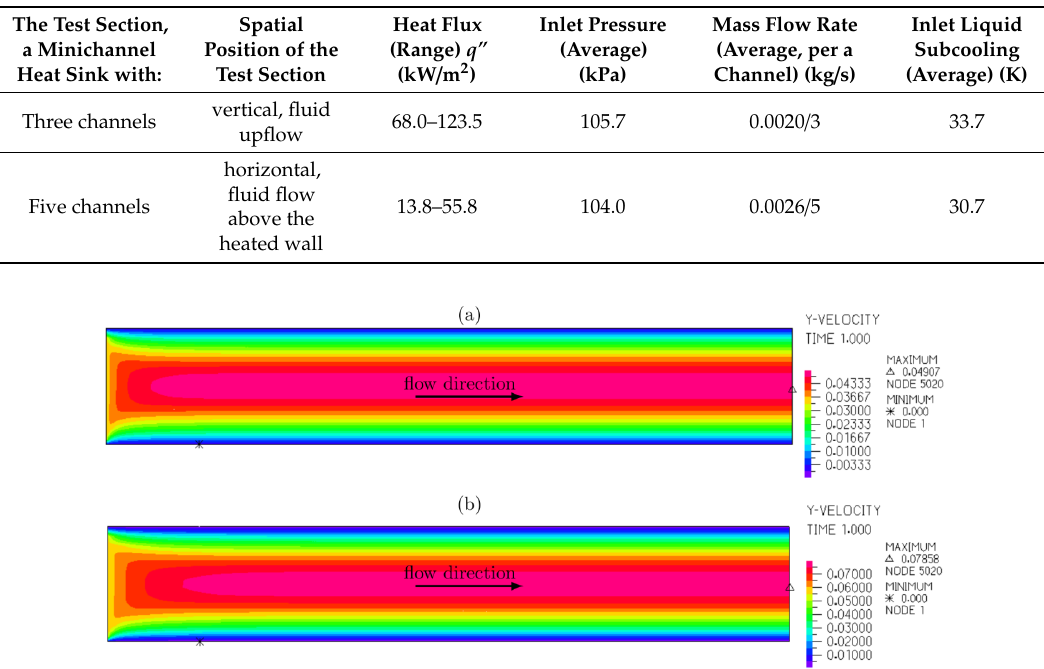
Figure 6. Distributions of the y -component of the fluid velocity vs. the distance from the adiabatic wall of the minichannel, obtained from computations in ADINA software (at six distances along the flow) Table 2. Main experimental parameters. and assumed in calculations based on the Trefftz functions; ( a ) the test section with three minichannels, q’’ = 68 kW/m 2 , ( b ) the test section with five minichannels, q’’ = 13.8 kW/m 2 .